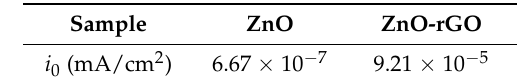
Table 1. Calculated value of i 0 for ZnO and